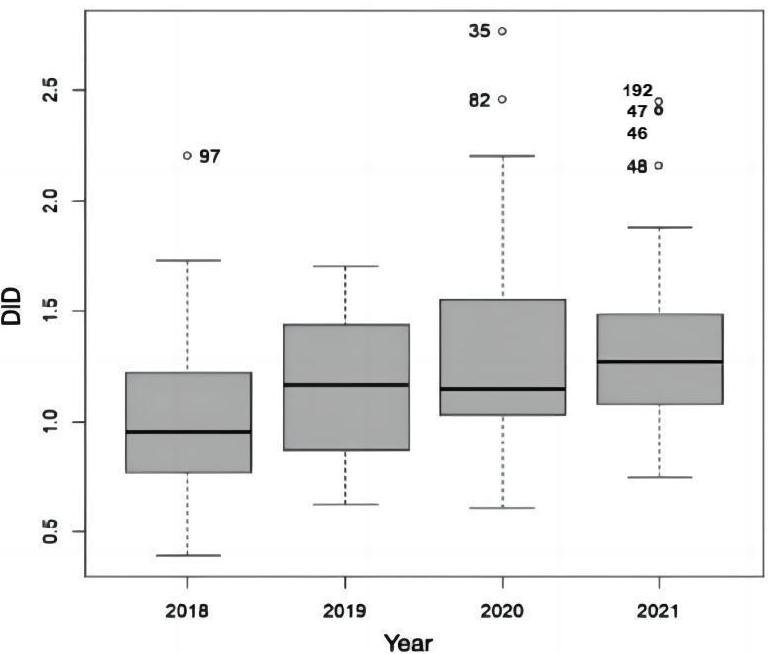
Figure 3. Annual evolution of the defined daily dose per 1000 inhabitants per day (DID) from 2018 to 2021 in Galicia (Spain).